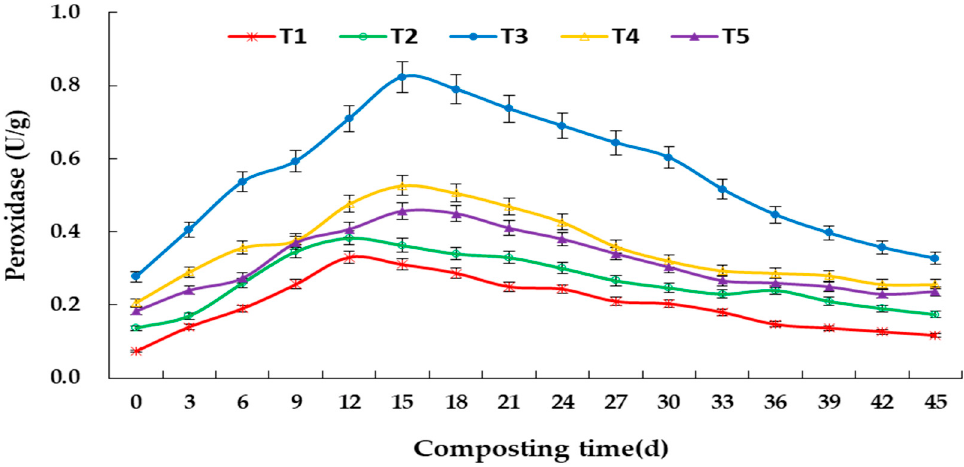
Figure 9. Changes of peroxidase activity during composting of corn straw and cow dung under different C/N ratios.